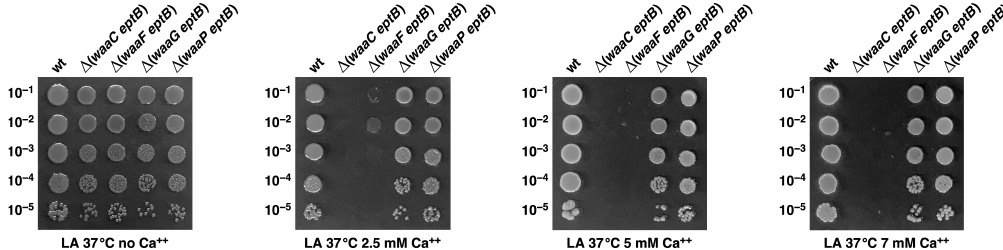
Figure 12. ∆ ( waaC eptB ) and ∆ ( waaF eptB ) bacteria exhibit sensitivity to Ca ++ , but ∆ ( waaG eptB ) and ∆ ( waaP eptB ) combina- tions behave like the wild type. Exponentially grown cultures of the wild type, its isogenic derivatives lacking the eptB gene, and one of the early LPS inner core biosynthetic enzymes were adjusted to an OD 595 of 0.1 and serially spot diluted at 37 ◦ C, either in LA agar alone, or supplemented with different concentrations of CaCl 2 . Plates were incubated for 24 h, and the data presented are from one of the representative